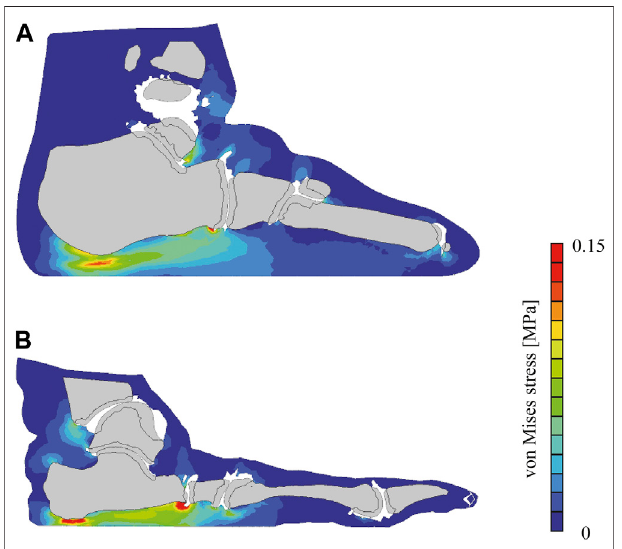
FIGURE 5 | Simulated von Mises stress distribution in human (A) and chimpanzee (B) feetduringsimulatedquietstanding.Crosssectionde fi nedas plane including calcaneal tuberosity and fi fth metatarsal head.